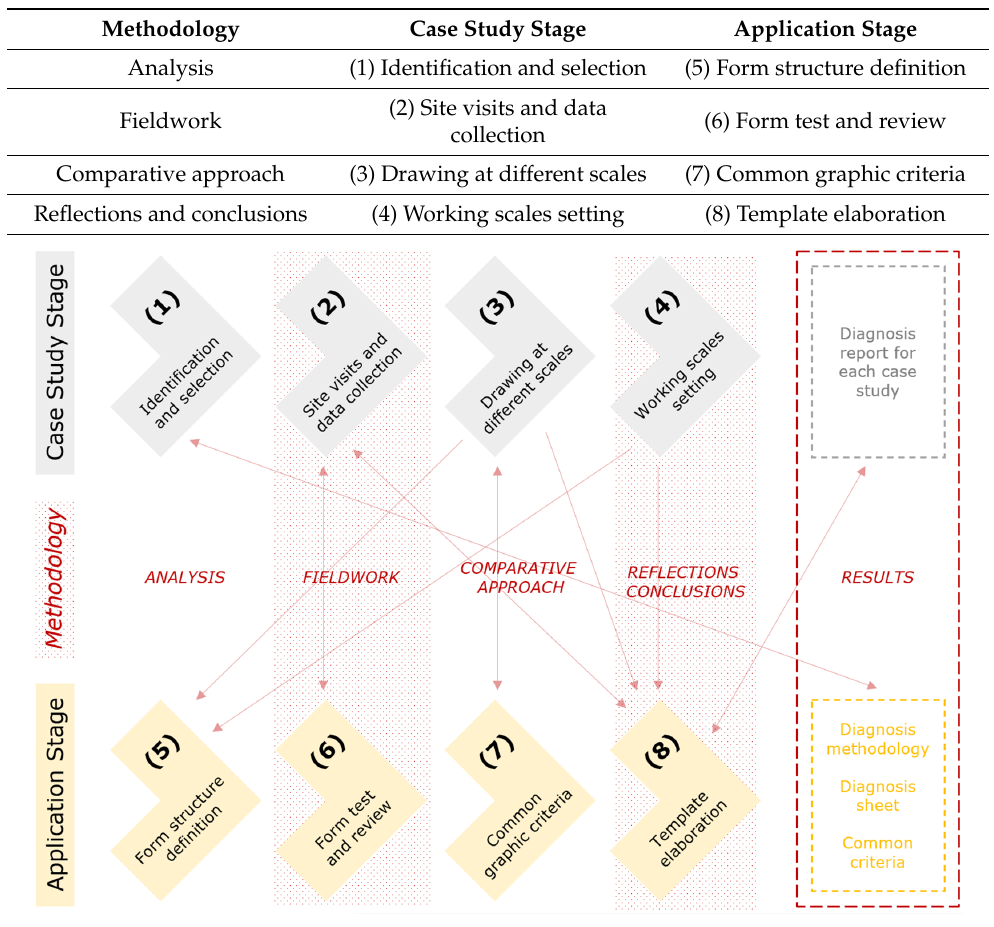
Table 1. Research process based on “Mediterranean Strategies” inductive methodology.